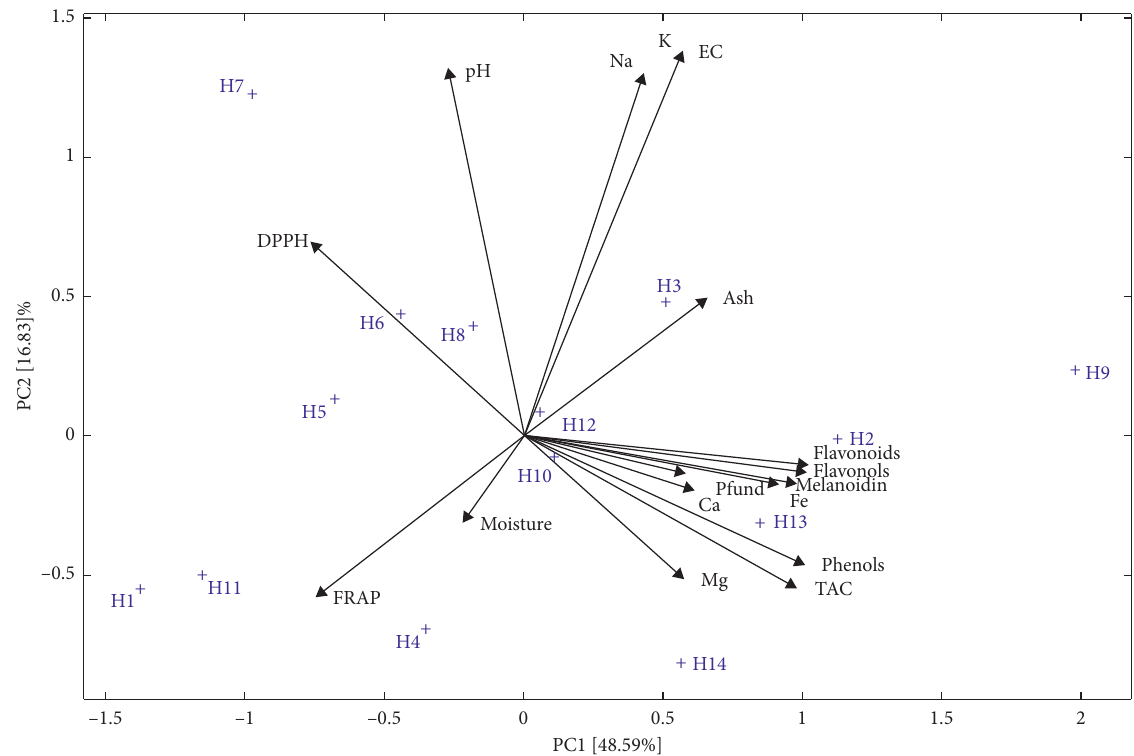
Figure 1: Principal component analysis (PCA) using all analysed